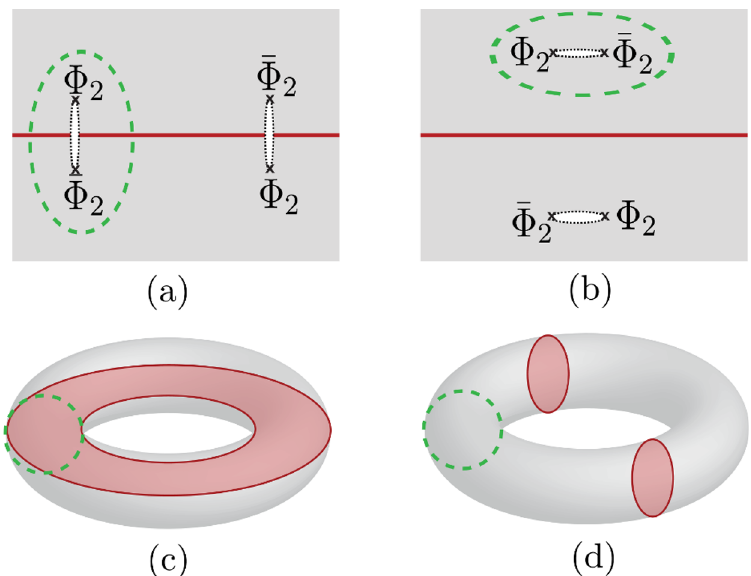
Figure 10 . CFT and bulk depictions of the path integral for computing the second Rényi entropy of two intervals. We indicate a Z 2 identification, whose fixed-point locus is drawn as a red line, that relates this to a BCFT whose boundary is the red line. (a) When the twist operators are near the Z 2 -line (in red), the corresponding bulk solution will fill in the cycle indicated by the green dashed line. The Z 2 -line and the bulk contractible cycle intersect each other. (b) When the twist operators are far from the Z 2 -line, the bulk contractible cycle (green) is now homologous to the Z 2 -line on each sheet. (c) The corresponding bulk solution when the twist operators are near the Z Z Z 2 -line. The bulk 2 -surface connects the two 2 -lines on each sheet. (d) The bulk solution when the twist operators are far from the Z 2 -line. There is now a disconnected bulk Z 2 -surface for each Z 2 -line on the boundary. Figure 11 . Entangled state of n CFTs produced by inserting twist and anti-twist operators into the Euclidean path integral for the vacuum state. As the branch cut is moved toward τ = 0 , the entanglement between the CFTs becomes large, and the τ = 0 spatial slice of the dual geometry becomes a connected multi-boundary wormhole. In the original picture, this surface is the ETW brane geometry in the gravitational calculation of Rényi entropy for an interval close to the BCFT